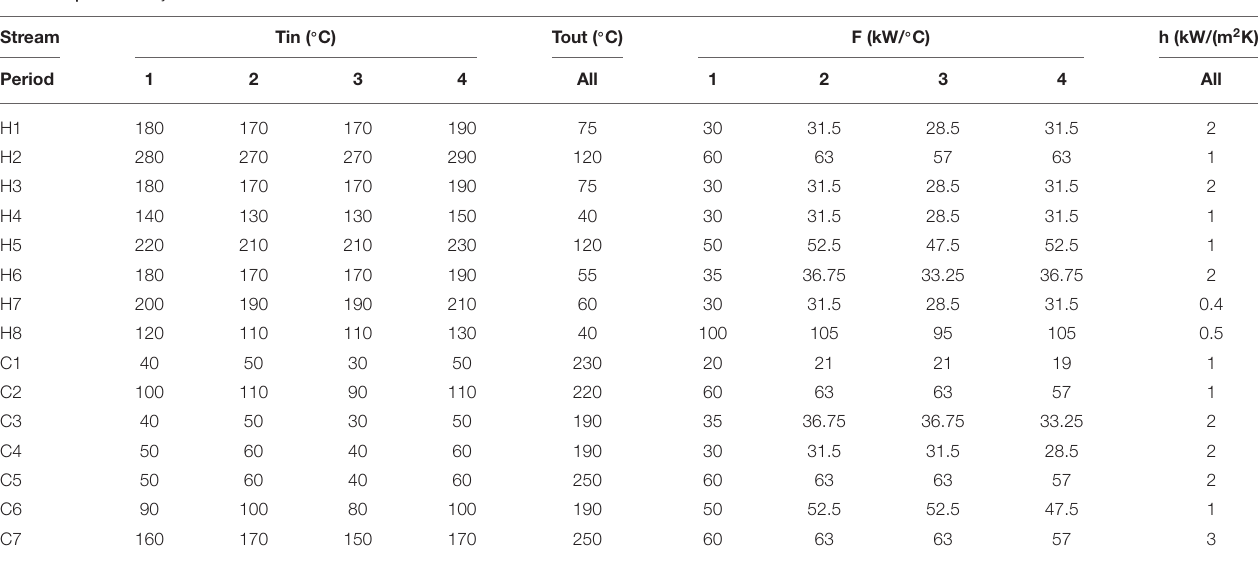
TABLE 1 | Case study stream